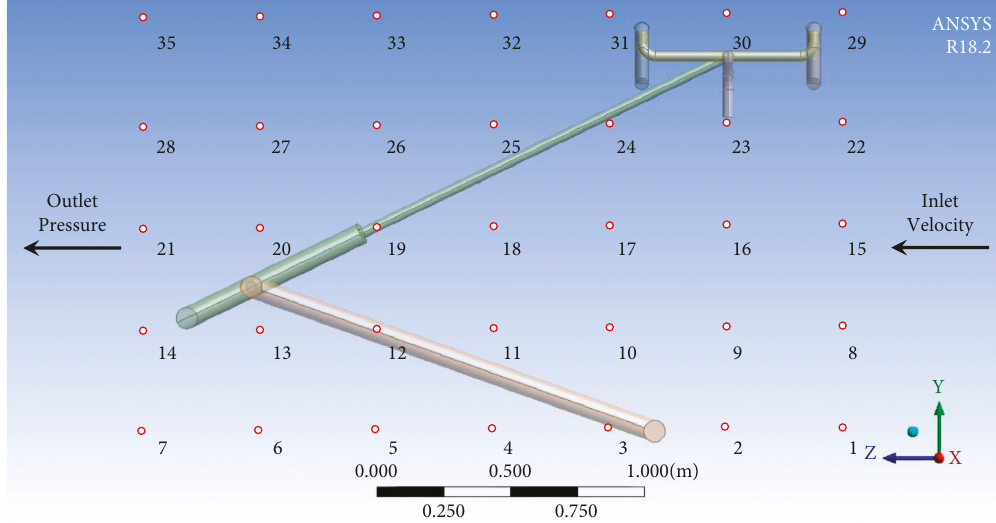
Figure 6: Computational receivers array positions.